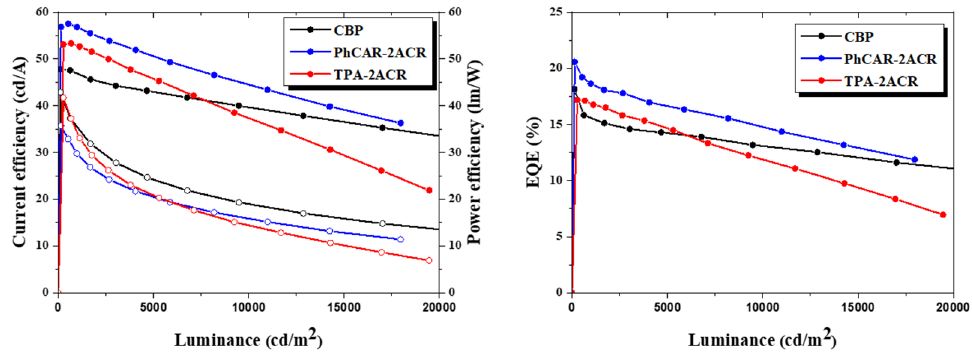
Figure 6. Luminescence vs. current and power efficiency, and luminance vs. external quantum effi- ciencies of yellow phosphorescent OLEDs with CBP, PhCAR-2ACR and TPA-2ACR as host materials.